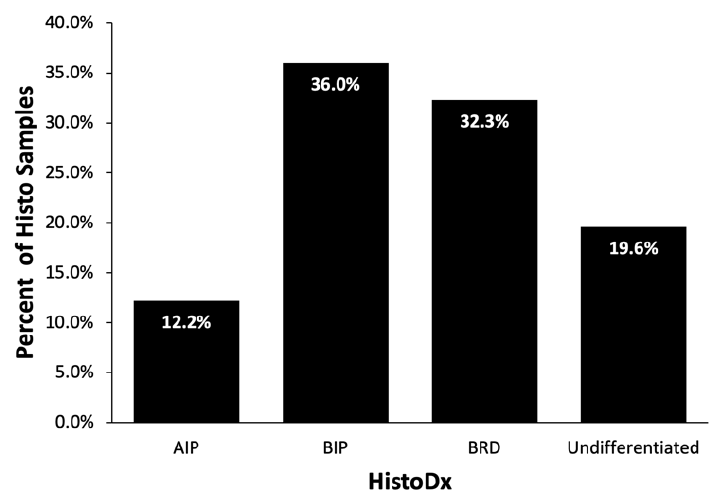
Figure 5. Frequency of pulmonary lesions based on histopathological diagnosis (HistoDx) for individual cattle ( n = 189) diagnosed with acute interstitial pneumonia (AIP), bronchopneumonia with interstitial pneumonia (BIP), bronchopneumonia (BP), or Undifferentiated (including healthy).